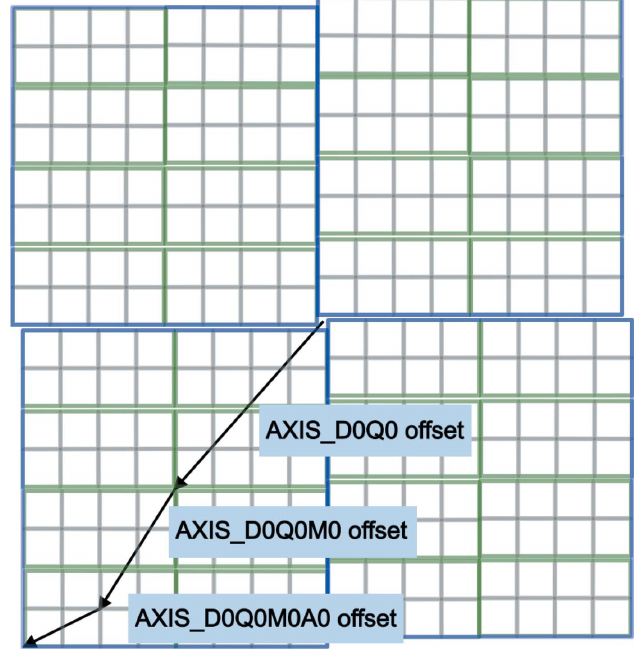
Figure 1 Schematic of the JF16M detector viewed from the source side, showing the hierarchical arrangement of panels. The quadrants are outlined in blue, the modules in green and the ASICs in gray. The offset components of the NeXus transformations are shown as arrows for the quadrant zero, sensor zero and ASIC zero. Note that the arrows point in the directions of the offsets, which are in the X – Y plane, not in the directions of the axes themselves, which are in the Z